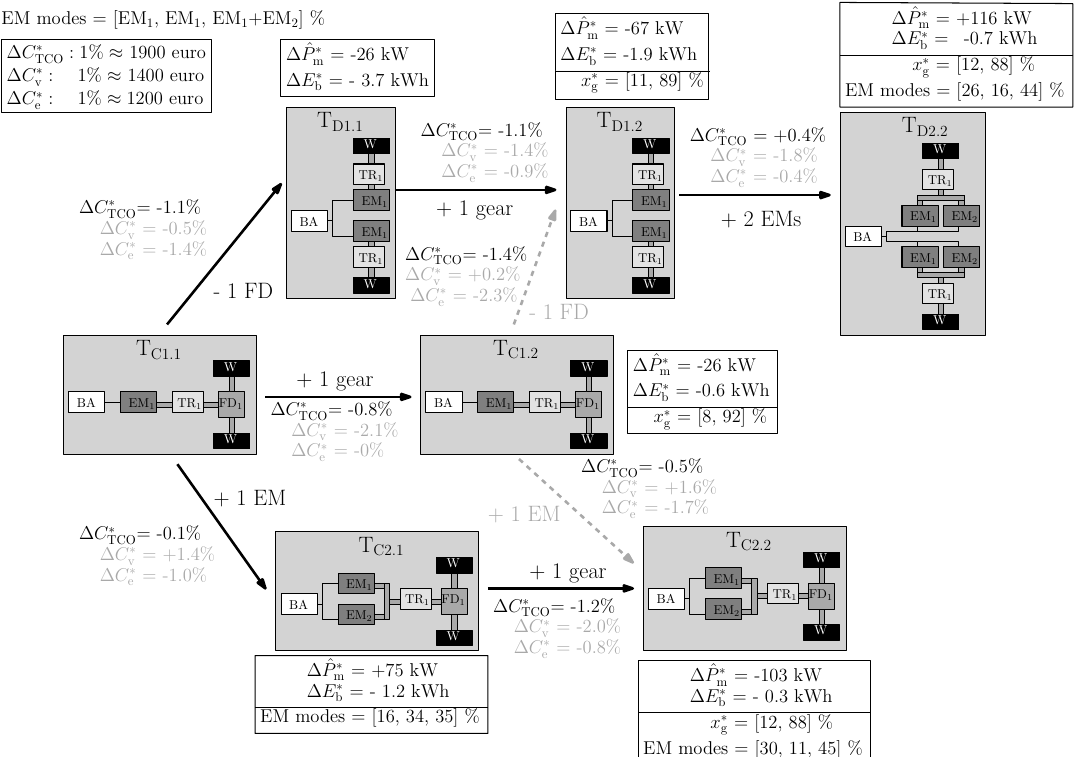
Figure 11. Design choice tree from the perspective of T C 1.1 , showing the impact on the optimal total-cost-of-ownership and optimal sizing parameters for the three topological design choices studied: (top) moving to a distributed drive; (middle) adding an extra gear to the gearbox; (bottom) adding an extra electric machine to the powertrain. The change in sizing parameters due to each choice is shown in the boxes above and below the configurations. In case control variables are present, the use of the gears and electric machine modes for driving the vehicle are mentioned for each